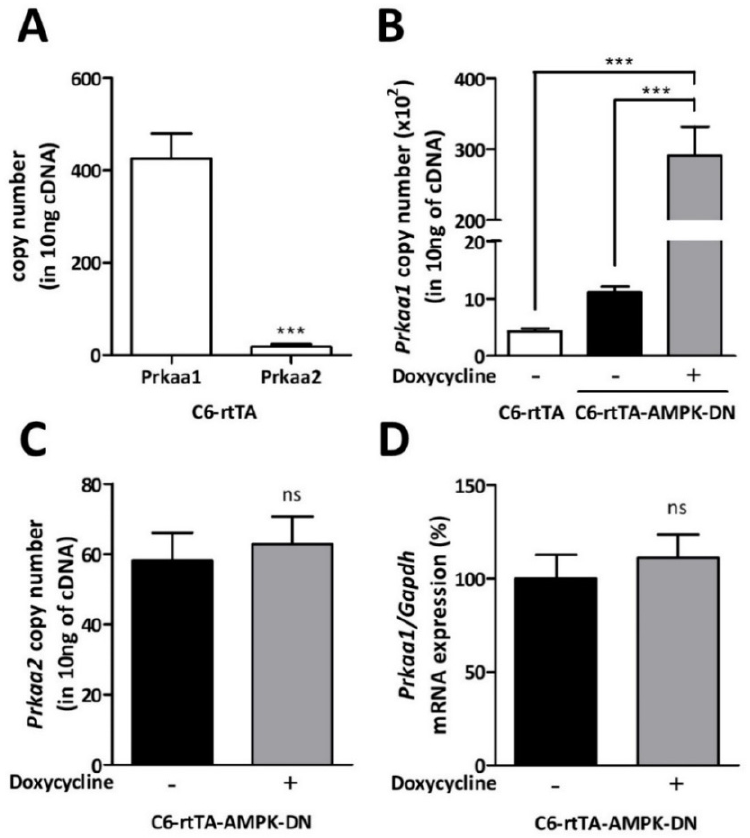
Figure 1. AMPK α mRNA expression in C6-rtTA and C6-rtTA-AMPK-DN cells. ( A ) The expression profile of AMPK α isoforms in C6-rtTA cells was quantified by RT-qPCR. Plasmid constructions carrying either the Prkaa1 or Prkaa2 coding sequences were used as standards for absolute quantification. ( B,C ) The mRNA expression of Prkaa1 (endogenous and mutated combined) ( B ) and Prkaa2